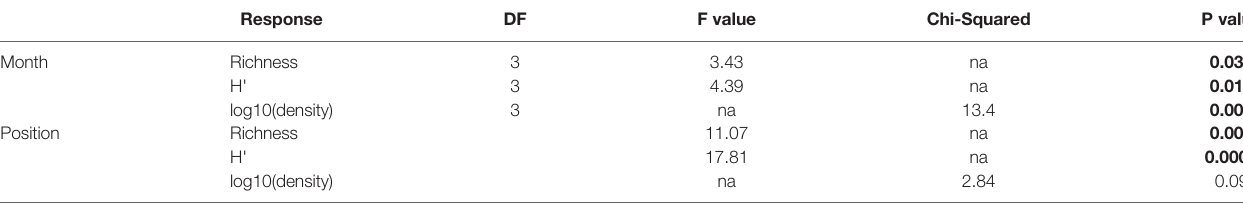
TABLE 1 | Results of two-way ANOVAs (richness, H ′ ) and Kruskal – Wallis test [log 10 (density)] against cruise and spatial position.